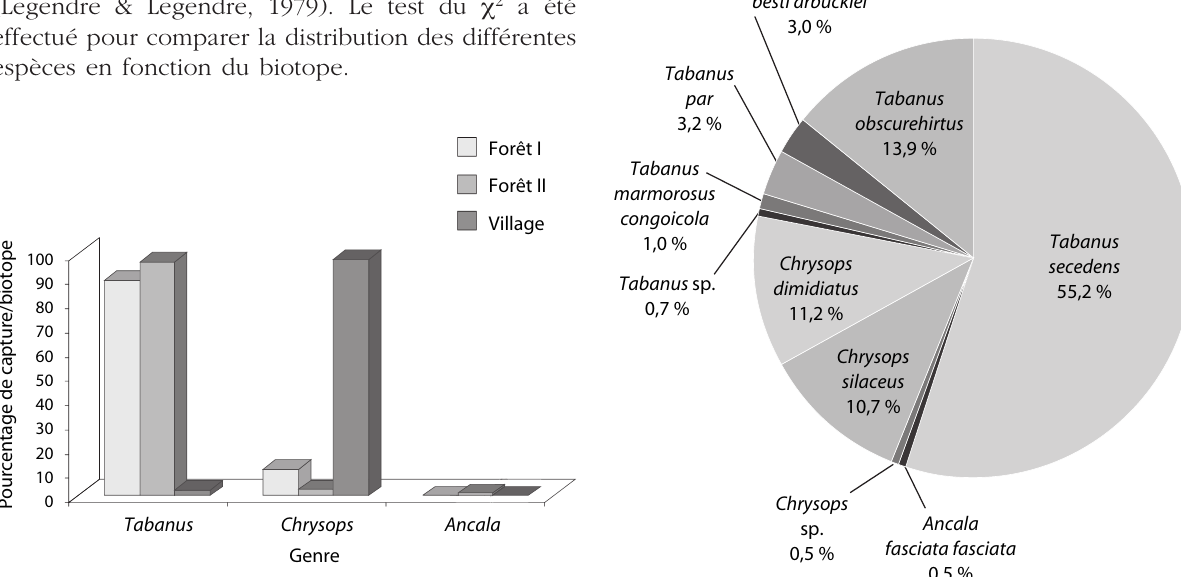
Figure 2. – Répartition des genres de tabanidés capturés en fonction des biotopes prospectés. Figure 3. – Répartition spécifique des espèces de tabanidés